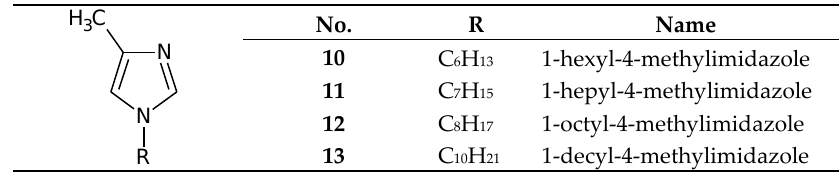
Figure 4. The 1-alkyl-4-metylimidazole molecule.